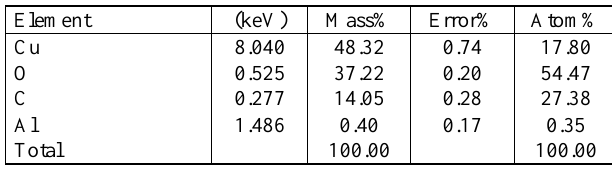
Table 1. Scanning electron microscope